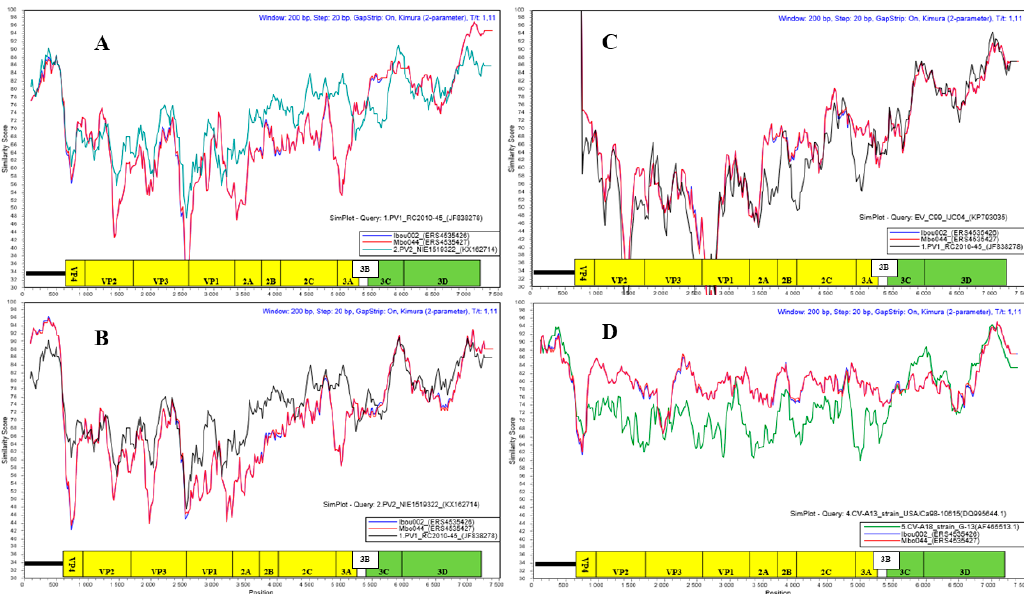
Figure 7. Pairwise comparison analysis of PV1_RC2010-45 (JF838278) ( A ), PV2_NIE1519322 (KX162714) ( B ), EV-C99_IJC04 (KP793035) ( C ) and coxsackievirus (CV)-A13_strain_USA/Ca98-10615 (DQ995644) ( D ) full-length genomes with Ibou002 and Mbo044 genomes of this study. Recombination was analyzed with the SimPlot software, version 3.5.1. Levels of pairwise identities between sequences were determined by using the Kimura (two-parameter) distance method with a 200 nt wide window and a step size of 20 nt.